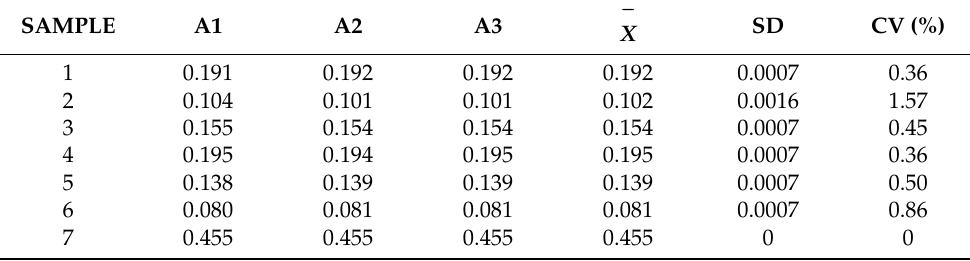
Table 9. Absorbances obtained for hydrophilic extracts of cream samples (FRAP